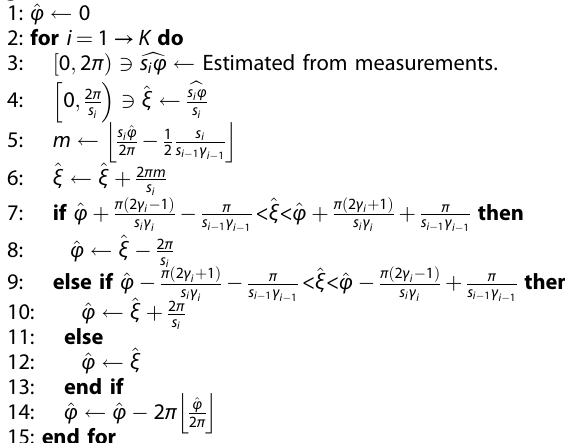
Algorithm 1 . Phase estimation 1: ^